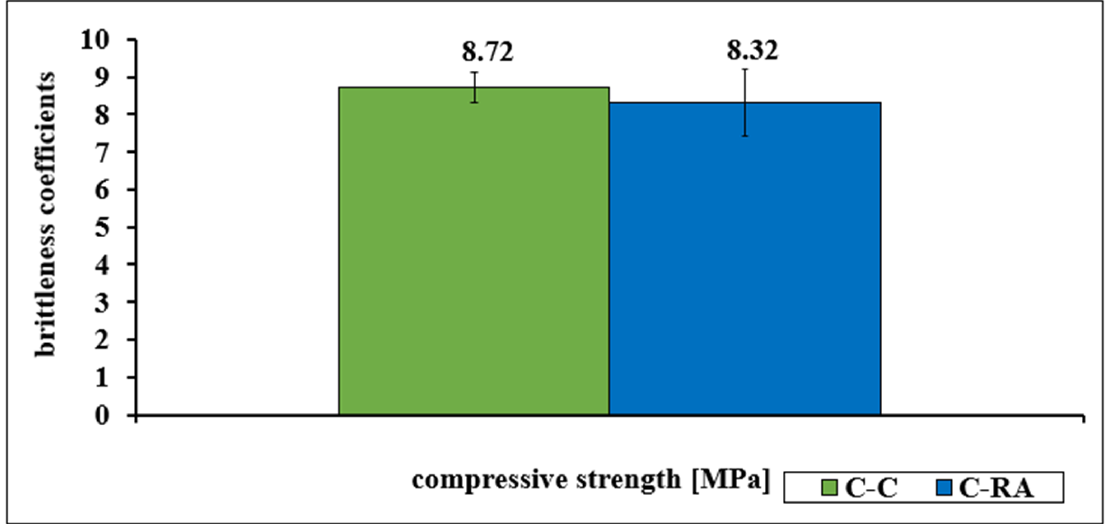
Figure 7. The dependencies of the brittleness coefficient for C-C and C-RA concrete.